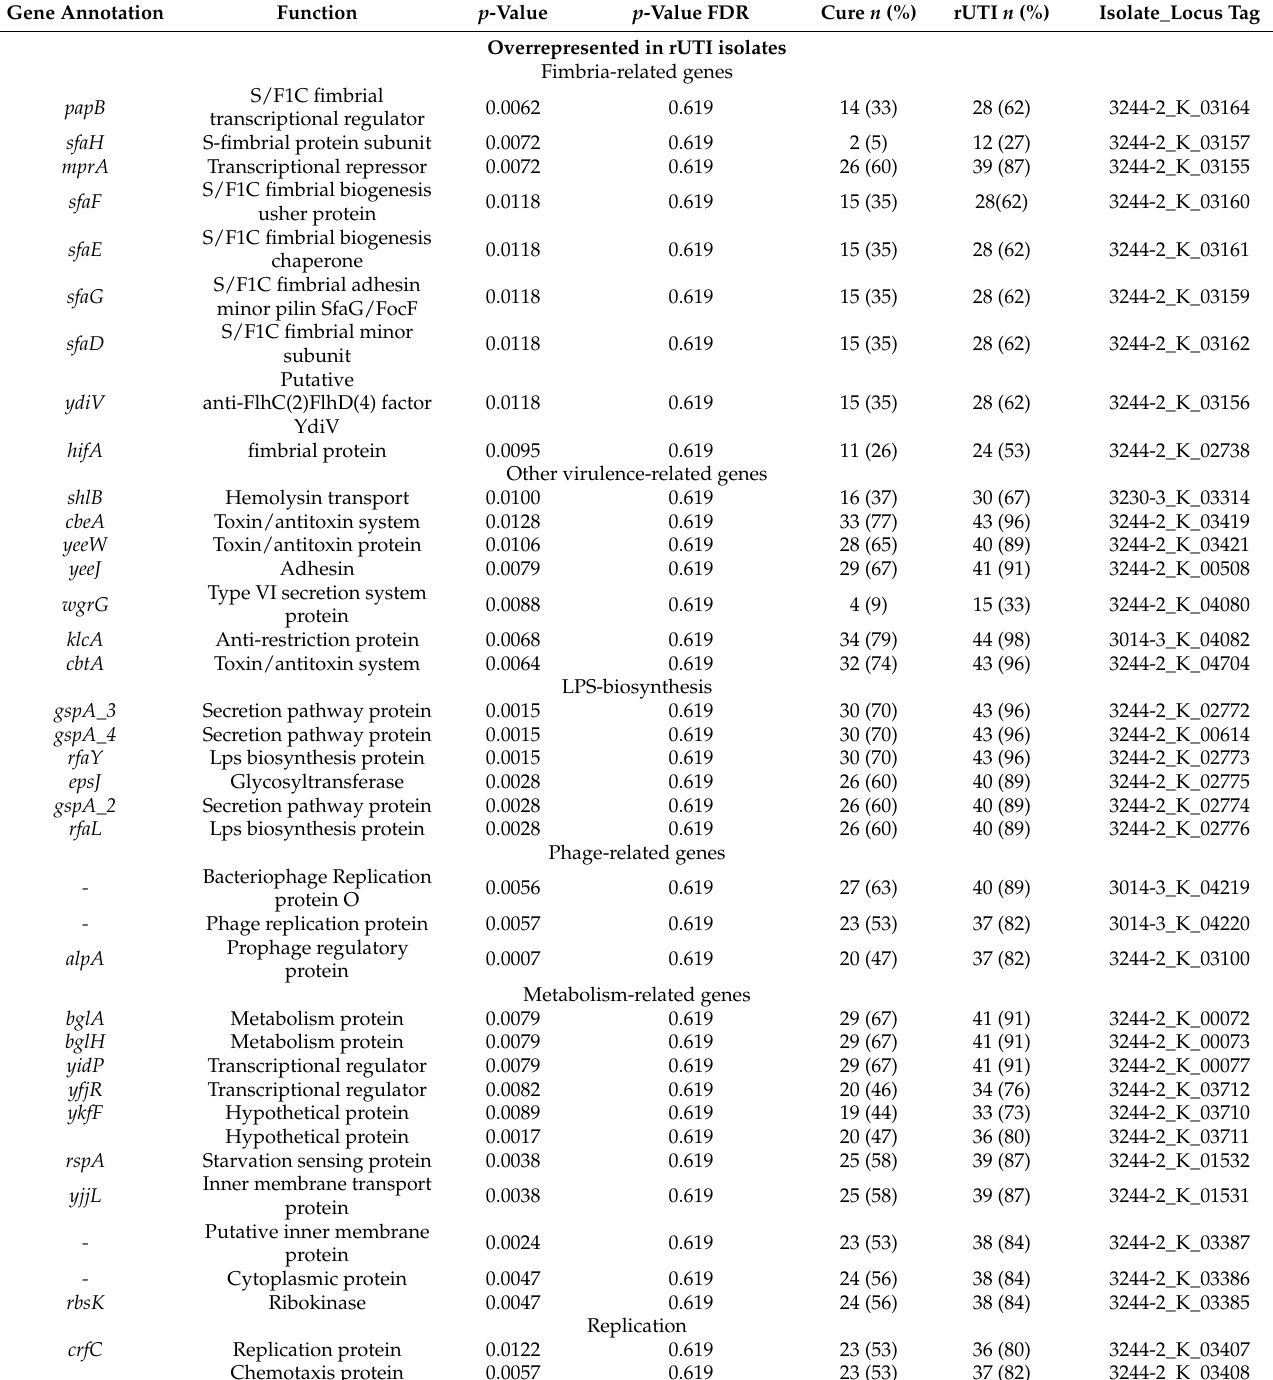
Table 1. Comparison of accessory genome of rUTI and non-rUTI isolates. Listed are top 50 p -values below 0.01 before false-discovery rate